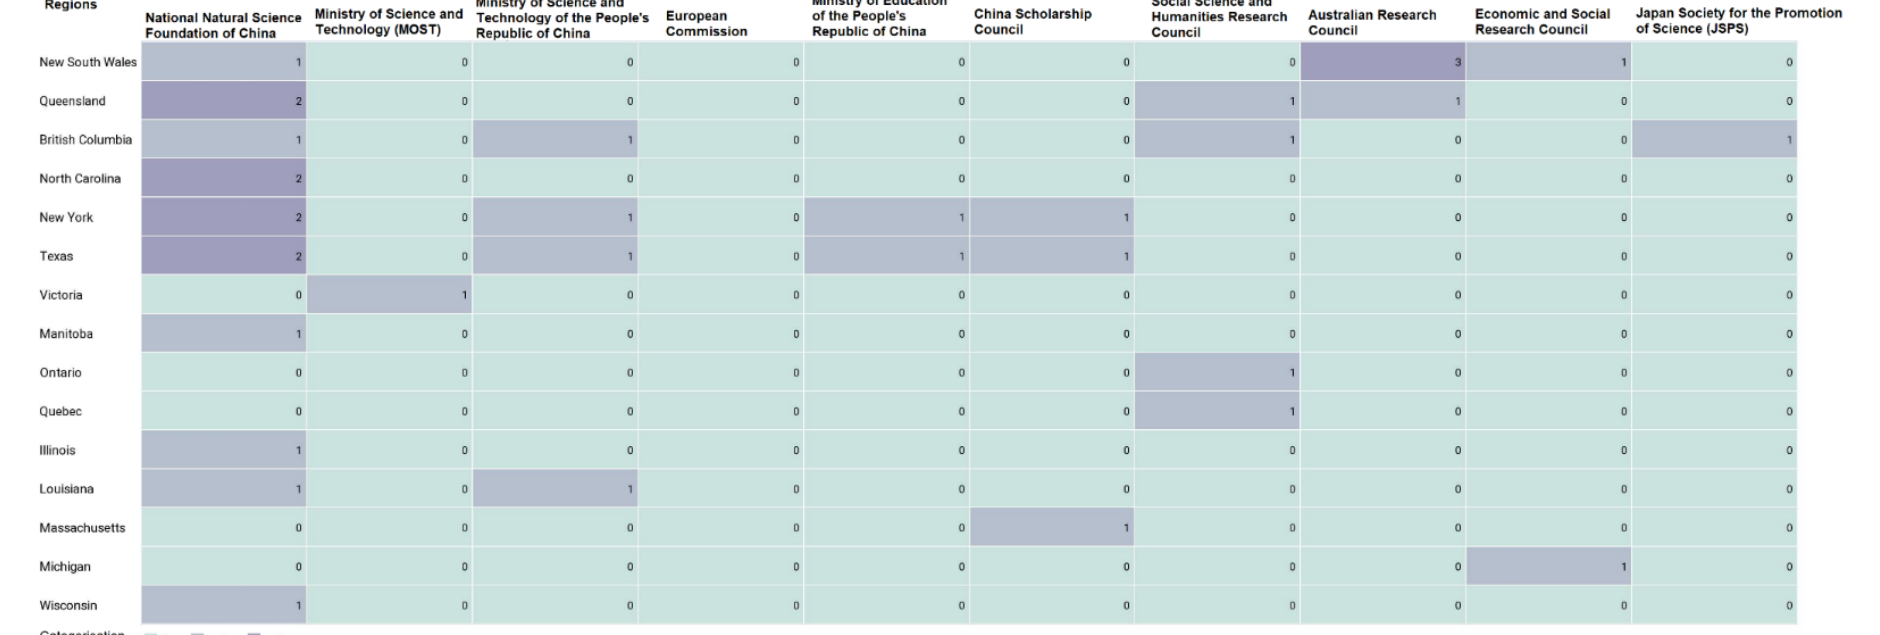
Figure 11 . Peering Publishers and Funders in Aerotropolis .